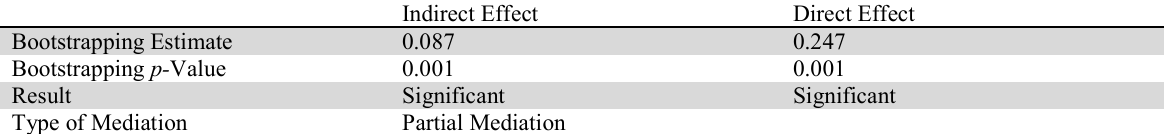
Fig. 1. Standardized Estimates for Actual behavior usage of EFFP